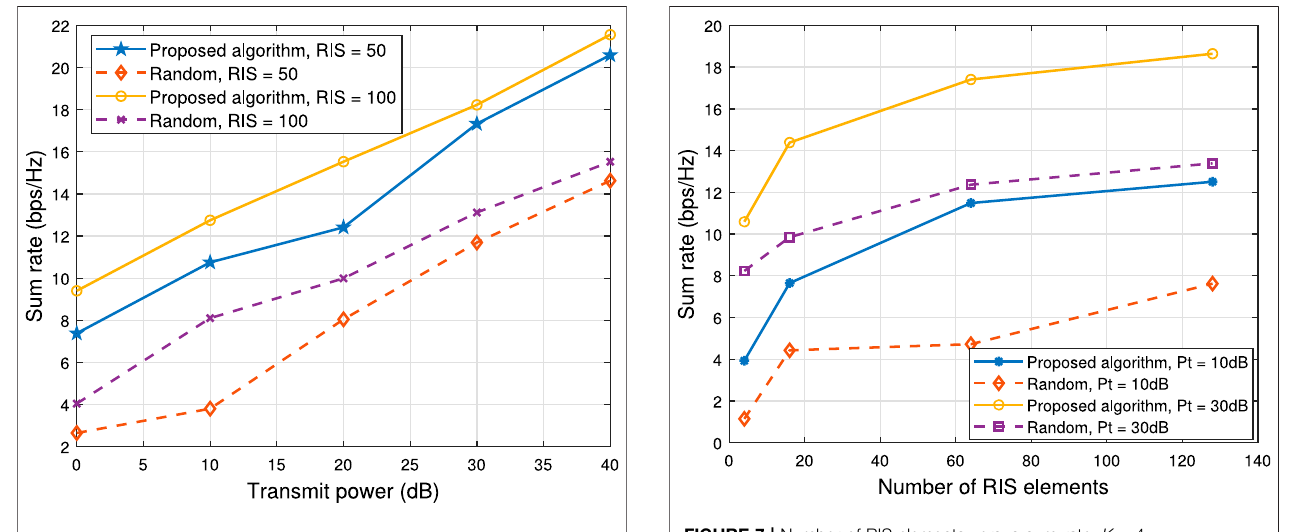
FIGURE 6 | Transmit power versus sum rate K = 4. FIGURE 7 | Number of RIS elements versus sum rate, K =